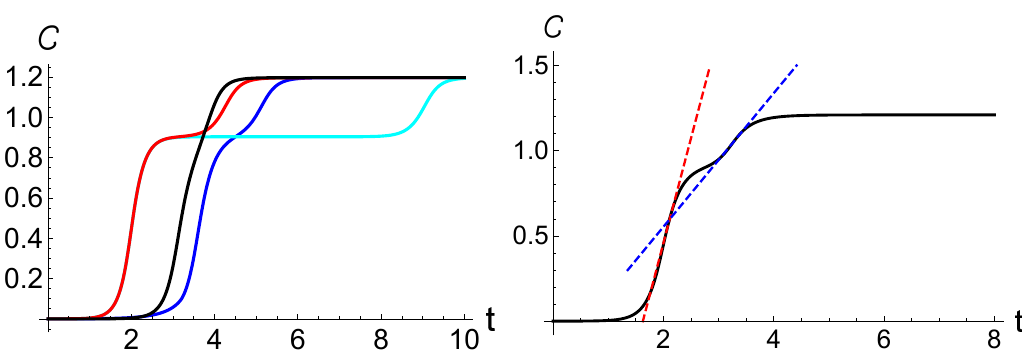
Figure 2 . Left: complexity for forward-backward evolved target state for perturbation in different directions with (cid:15) = − 6 , (cid:15) = − 1 , λ = 0 . 1 Cyan: δ(cid:15) = 0 . 001 , δ(cid:15) = 0 , δλ = 0 , Blue: δ(cid:15) = 0 , 1 2 1 2 1 δ(cid:15) 2 = 0 . 001 , δλ = 0 , Black: δ(cid:15) 1 = 0 , δ(cid:15) 2 = 0 , δλ = 0 . 001 , Red: δ(cid:15) 1 = 0 . 001 , δ(cid:15) 2 = 0 . 001 , δλ = 0 . Right: complexity display different Lyapunov when (cid:15) parameters for the system and bath oscillators are different. Here we took (cid:15) = − 6 , (cid:15) = − 2 , λ = 0 . 1 , δ(cid:15) = 0 . 001 , δλ = 0 . 001 The two slopes are 1 2 displayed by red and blue dashed lines.